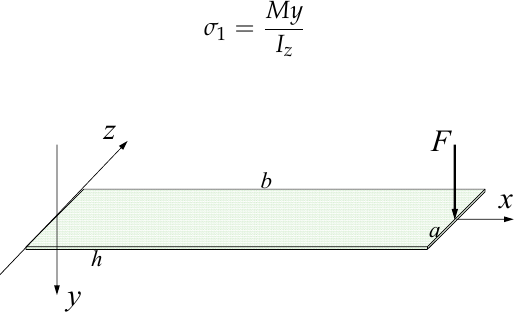
Figure 2. The cantilever-based PVDF sensor.